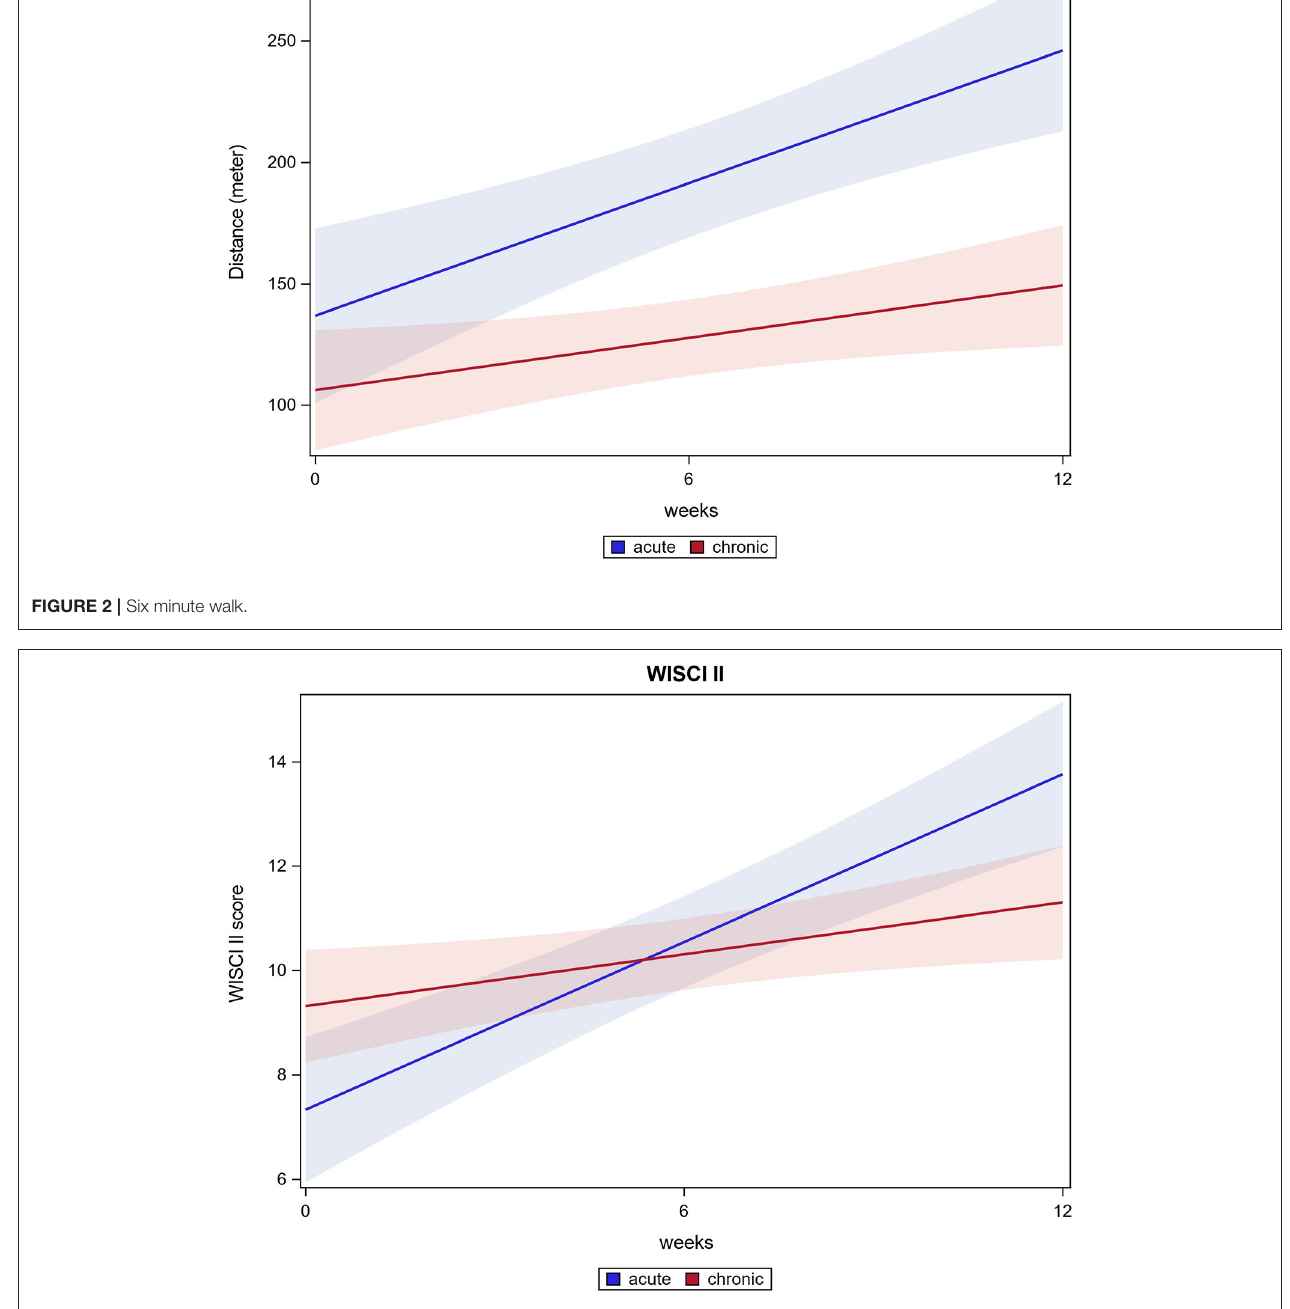
FIGURE 3 | WISCI II